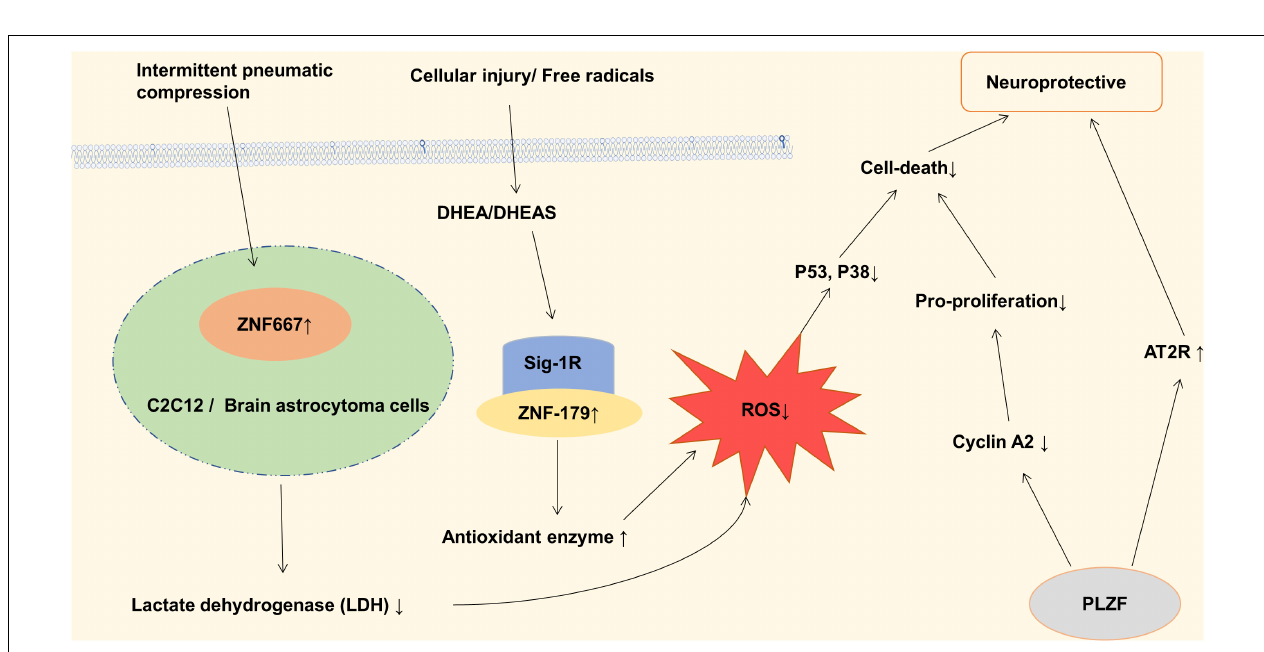
FIGURE 3 | Zinc finger proteins (ZNF) associated with neuroprotective in ischemic stroke. Dehydroepiandrosterone (DHEA) and its sulfated analog (DHEAS) in adrenal and cerebral glands increase antioxidant enzyme levels, inhibit oxidative stress, and reduce nerve cell death through Sig-1R and ZNF-179 pathway. ZNF667 plays a role as a transcription suppressor in IPC-induced neuroprotection, thereby protecting C2C12 and brain astrocytoma cells from oxidative stress induced damage. Promyelocytic leukemia zinc finger (PLZF) induces neuroprotective endophoric phenotypes by regulating neuroprotective and neurotoxic target genes, such as AT2R and Cyclin